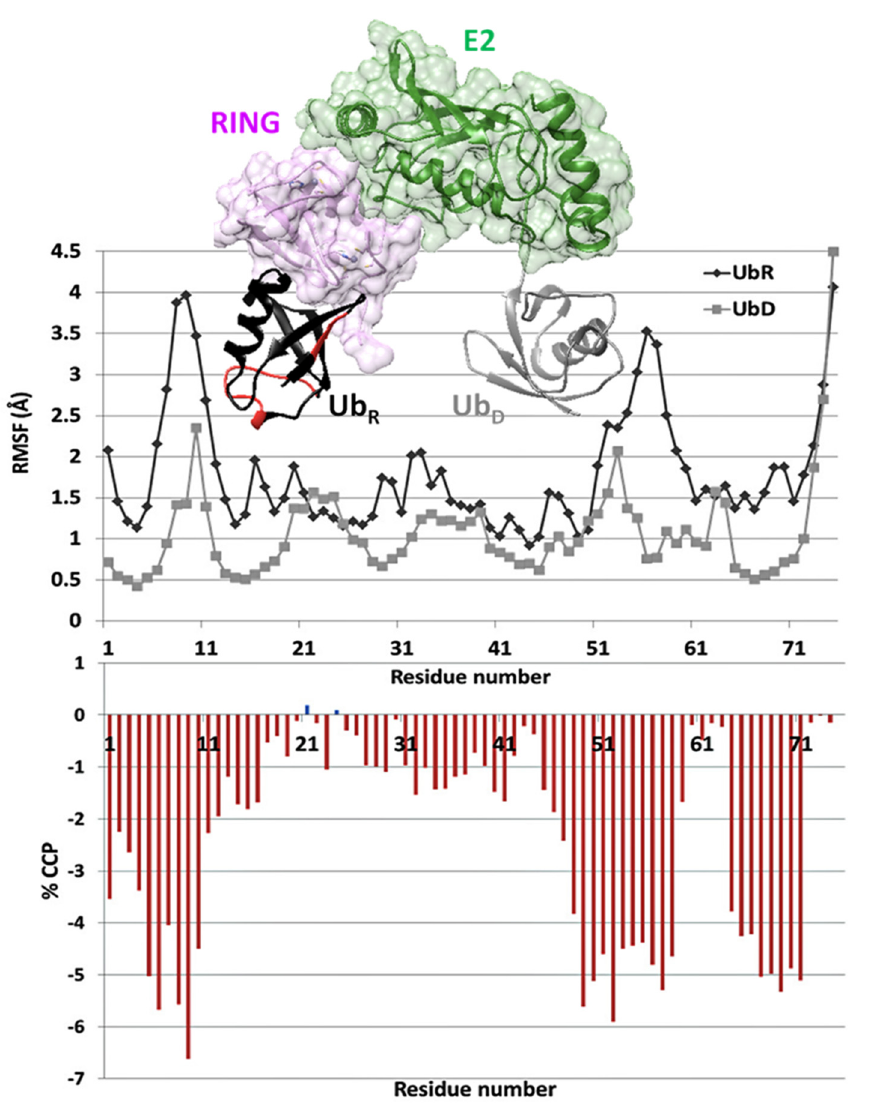
Figure 5 . C α RMS fluctuations of Ub R (black symbol) and Ub D (grey symbol) [38] and % CCP values between Ub R and Ub D of the Ub R –RING–E2–Ub D complex (PDB ID: 5D0K). The areas of Ub R with increased flexibility as detected by % CCP values are shown in red.